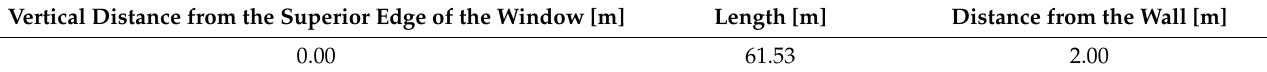
Table 9. Eave characteristics.